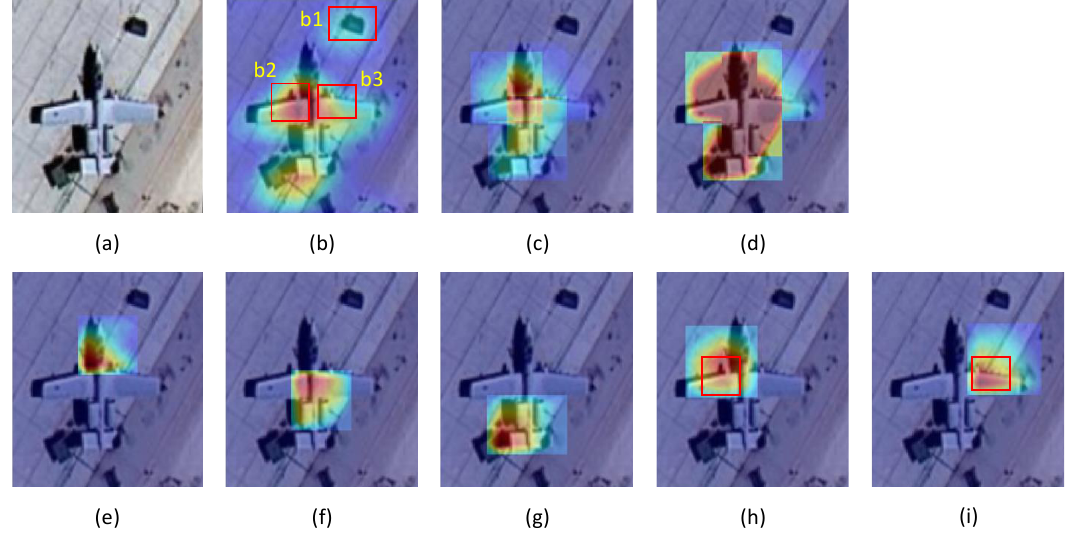
Figure 8. Heatmaps of aircraft Type0 before and after adding part feature fusion method. ( a ) original image, ( b ) heatmap corresponding to conv5_4 without part feature fusion, ( c ) the result after concatenation of the heatmap of each part, ( d ) the result after cutting off the heat value at the threshold, and ( e – i ) are the heatmaps of five parts,